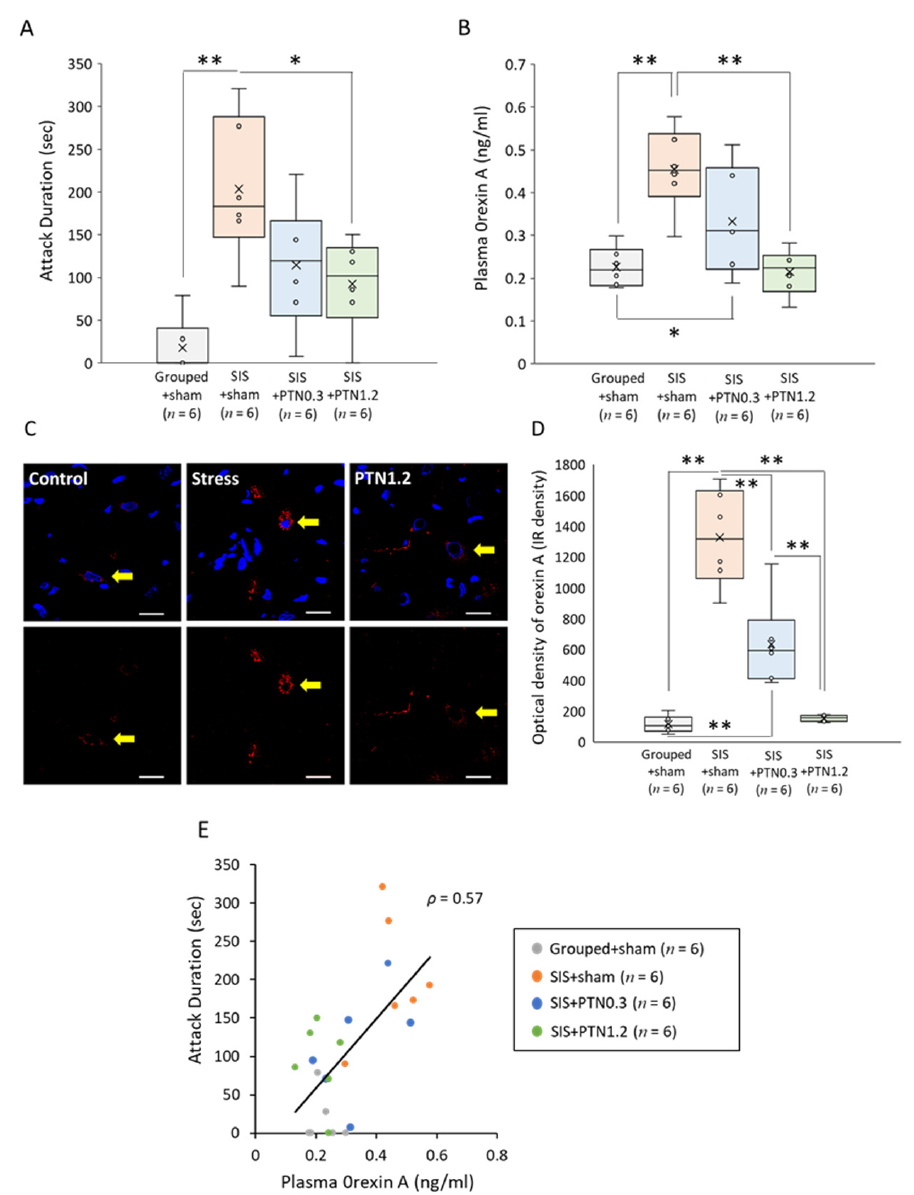
Figure 4. Aggressive behavior test and plasma orexin A level following the social isolation stress load. ( A ) Attack duration during the 10 min aggressive behavior test. Increased attack duration induced by social isolation stress was significantly inhibited after PTN treatment (1.2 mm) (* p < 0.05). ( B ) Plasma orexin A level. Increased orexin A level induced by social isolation stress was significantly inhibited due to PTN treatment (1.2 mm) (** p < 0.01). Horizontal lines within boxes denote median values, and x-marks denote mean values. ( C ) Immunofluorescent staining of orexin A in in the lateral hypothalamus. The upper row includes orexin A and nuclei, and the lower row includes only orexin A. Red, orexin A; blue, DAPI (nuclei). Yellow arrows indicate orexin neurons, and the white scale bar is 20 µ m. ( D ) The fluorescence intensity quantification of orexin A immune reactivity (IR). Increased orexin A level induced by social isolation stress was significantly inhibited due to PTN treatment (** p < 0.01). ( E ) Correlation between the attack duration and the orexin A level. A significantly positive correlation was observed between them ( ρ = 0.57, p < 0.01). * p < 0.05, ** p < 0.01. SIS, social isolation stress; PTN, press tack